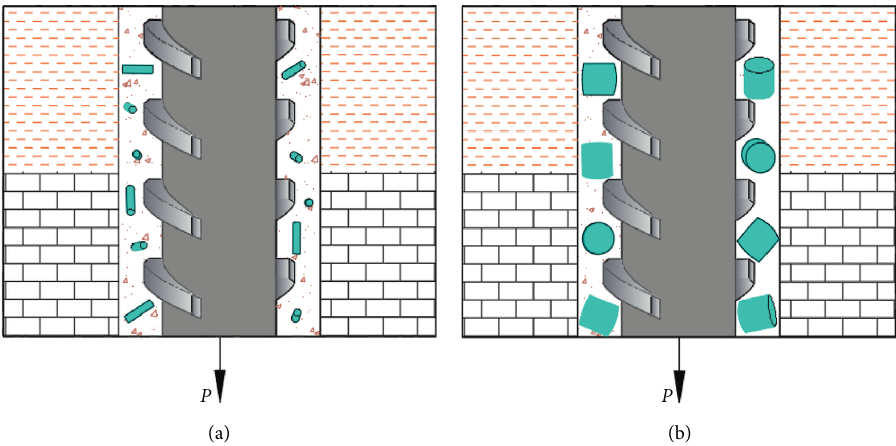
Figure 5: Distribution state and working mechanism of steel segments in resin grout. (a) Distribution state of the tenuous steel segment and working mechanism in resin grout; (b) distribution state of the coarse steel segment and working mechanism in resin